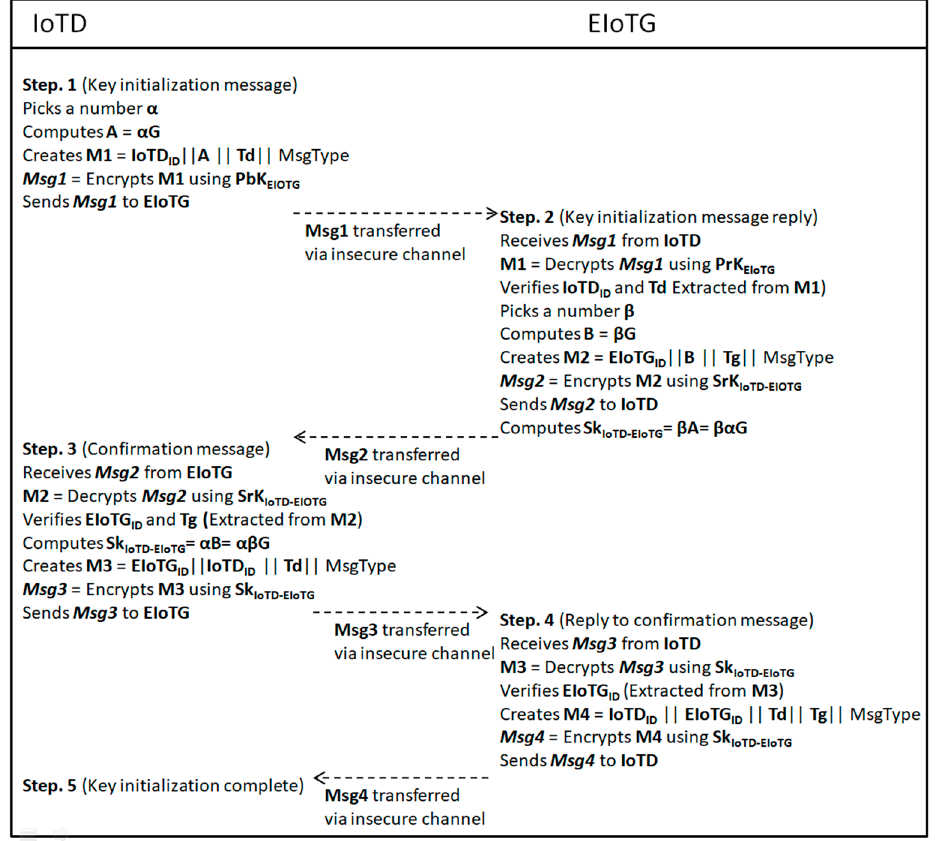
Figure 13. Message flow diagram for session key initialization between IoTD and EIoTG.